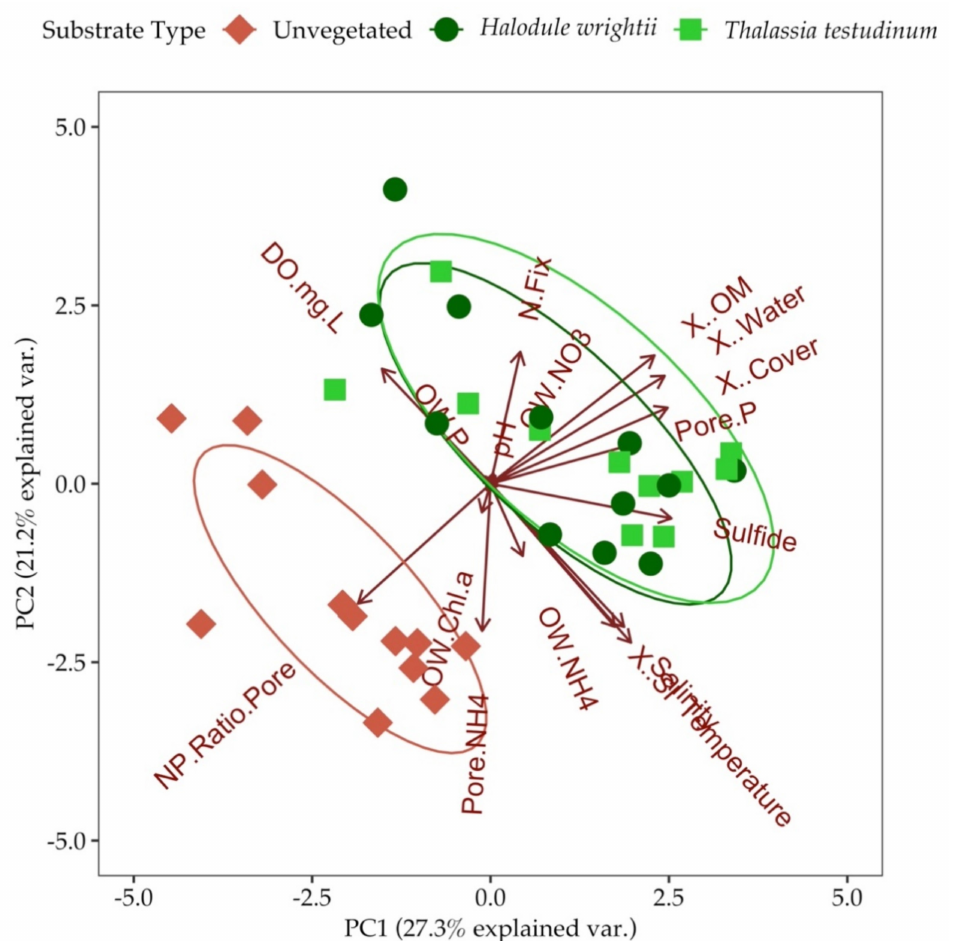
Figure 7. Principal component analysis (PCA) biplot showing relatedness of variables based on substrate type. The variables included in this plot are pH (pH), temperature (Temperature), salinity (Salinity), surface irradiance (X..SI), dissolved oxygen (DO.mg.L), water column chl a (OW.Chl.a), water column ammonium (OW.NH4+), water column DIP (OW.P), water column nitrate (OW.NO3), percent areal seagrass cover (X..Cover), sediment water content (X..Water), sediment organic matter content (X..OM), porewater ammonium (Pore.NH4), porewater DIP (Pore.P), nitrogen fixation (N.fix), porewater sulfide (Sulfide, and porewater N:P (NP.Ratio.Pore). The relatedness of temperature, salinity and surface irradiance overlap their respective vectors in the lower right-hand corner of the